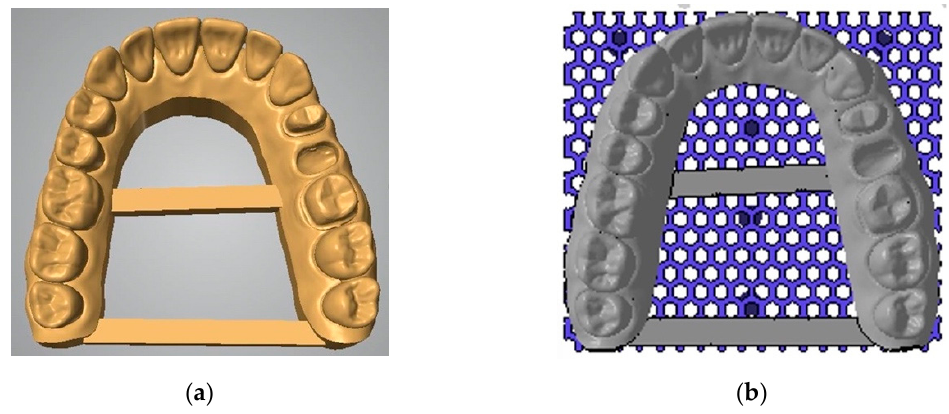
Figure 1. Conversion of TRIOS standard tessellation language (STL) files into 3D printable data sets with ( a ) model builder software including two stabilizing bars ( b ) virtual preparation for 3D printing using a base plate with hexagonal cell design.